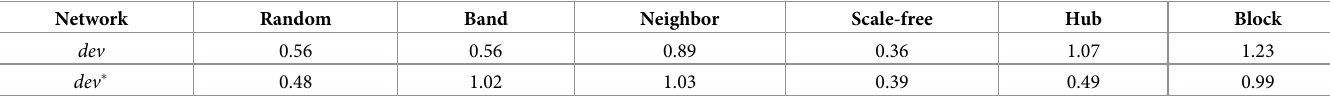
Table 5. Deviations from the exchangeable condition of six different network structures.